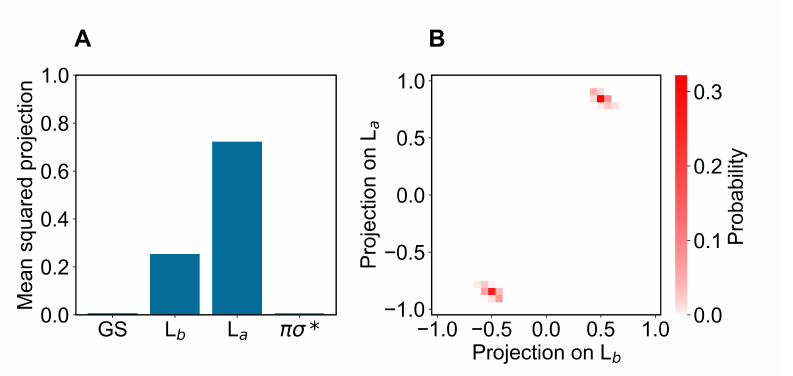
Figure 7. ( A ): Mean-squared projections of the perturbed first electronic excited state of indole, on the first four unperturbed electronic eigenstates (the ground state GS, the excited states L b , L a and the dark state πσ ∗ , in the figure ordered according to increasing energy) as obtained at the L a geometry by the L a state MD ensemble. ( B ): Probability distribution of the pair values of the projections of the perturbed first electronic excited state of indole, on the L b and L a states as obtained at the L a geometry by the L a -state MD